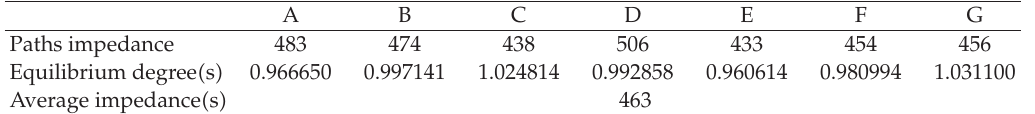
Table 5: After application of